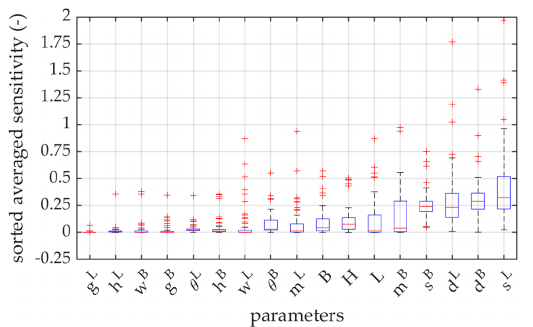
Figure 6. Sensitivity box plots of the 17 parameters considered (sorted in ascending order).